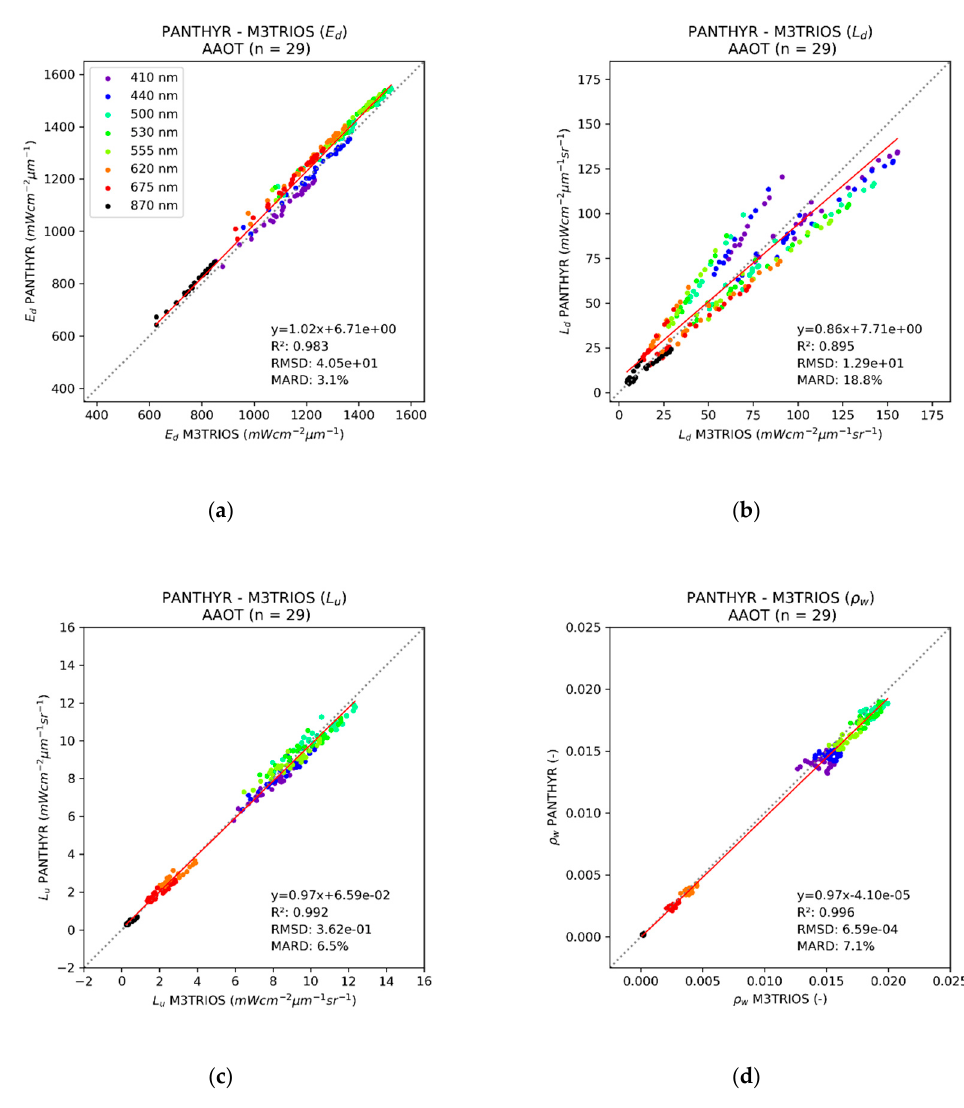
Figure 7. Scatterplot for selected wavelengths comparing PANTHYR data with M3TRIOS system data for ( a ) E d , ( b ) L d , ( c ) L u , and ( d ) ρ w for 29 matchup stations. Linear regression statistics are given, including the root-mean-square difference (RMSD) and the mean average relative difference (MARD).